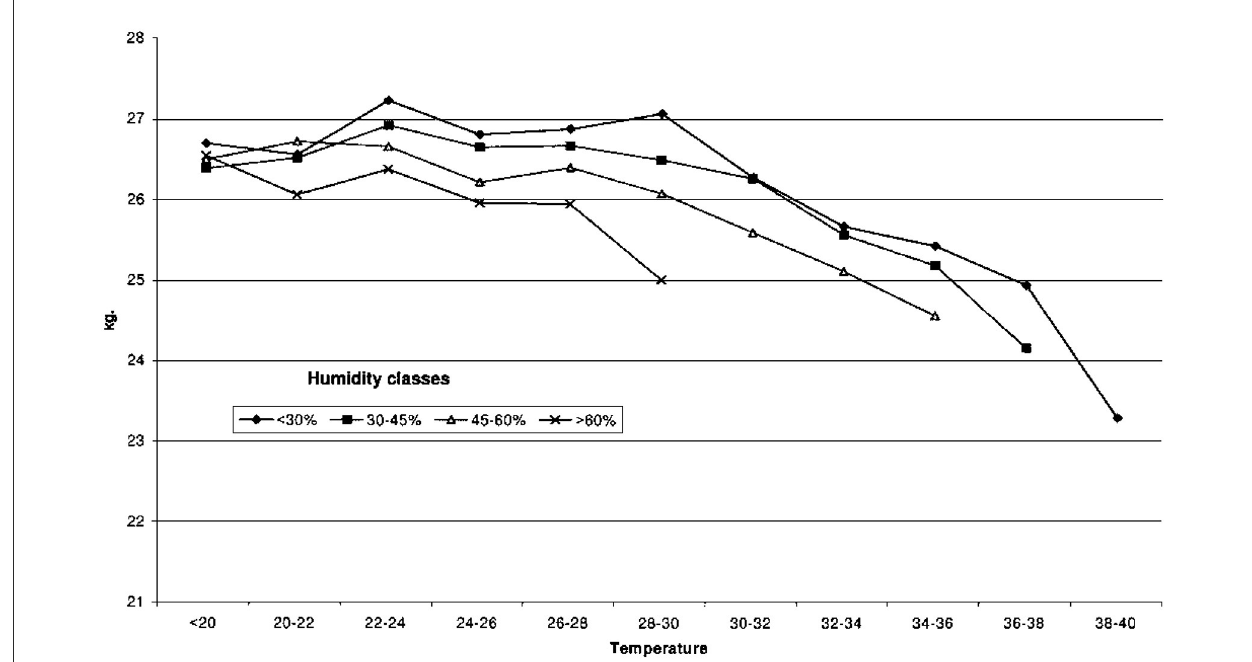
FIGURE3 For milk production, the yield was relatively constant up to about 24 ◦ C and then began to decline as the temperature increased. Adapted from the study developed by Ravagnolo et al. (35).